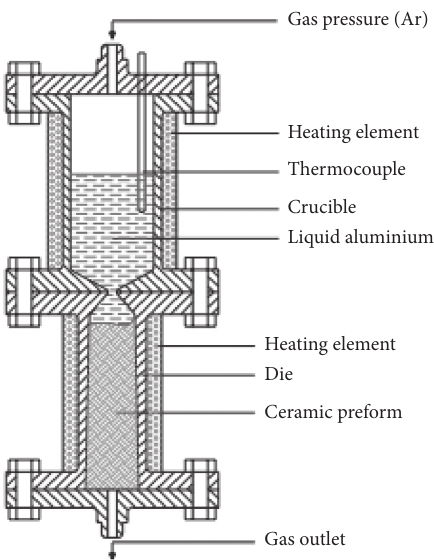
Figure 6: Schematic representation of the infiltration system